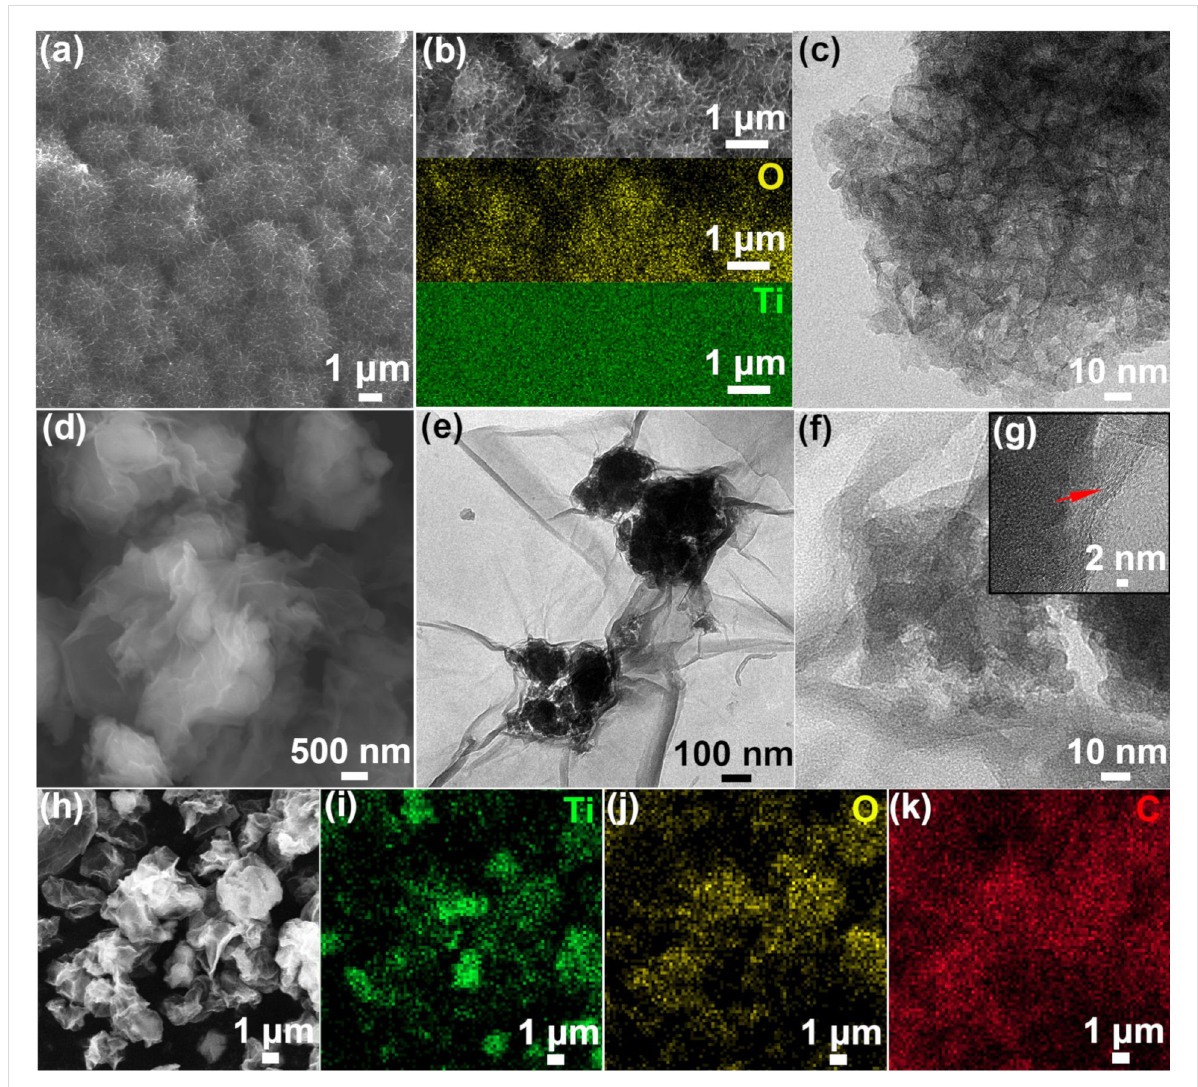
Figure 3: (a) SEM image, (b) element maps and (c) TEM image of the as-prepared nanoporous TiO 2 particles. (d) SEM image, (e) TEM image, (f, g) HRTEM images and (h–k) EDS mapping of the as-prepared TiO 2 /GO